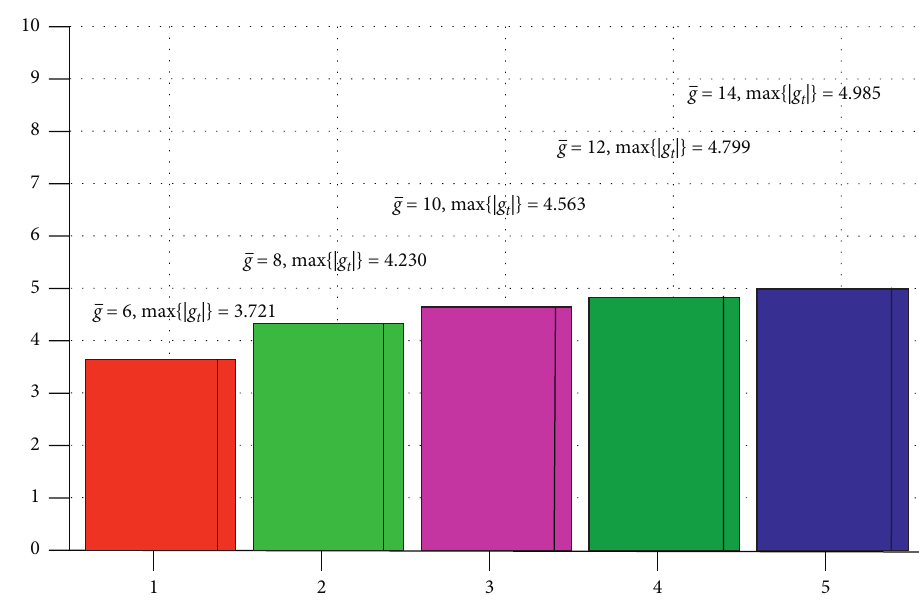
Figure 11: Comparison of the actual control g